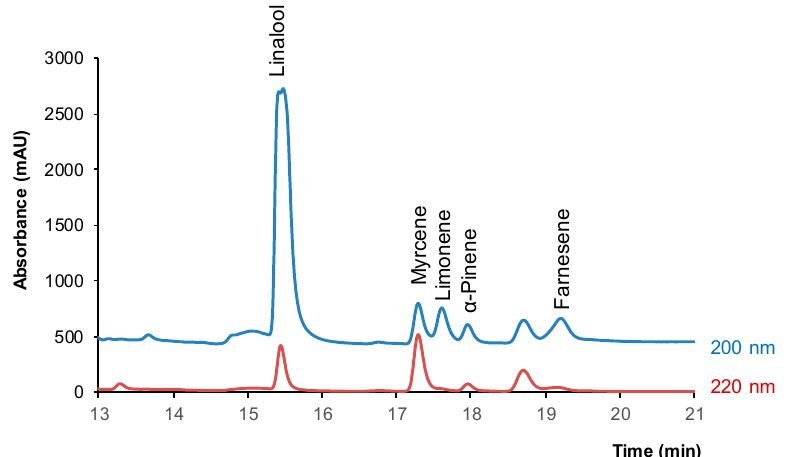
Figure 1. Chromatograms obtained under the selected conditions at 200 nm and 220 nm for a standard solution of the tested compounds (5 µ g mL − 1 each). For other experimental details, see text. Table 2. Times of retention (t r ) and analytical parameters obtained with the proposed